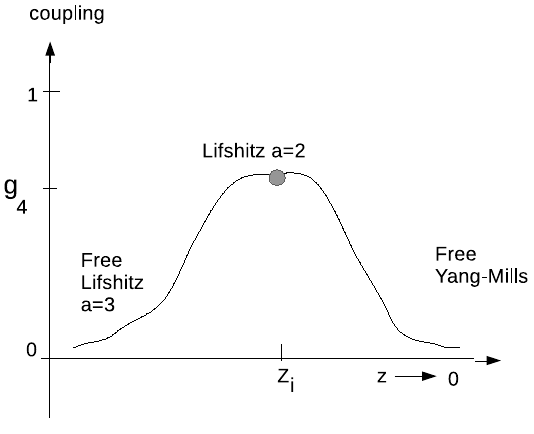
Figure 1 . There is a fixed point at z = z i where coupling is maximum g it the coupling decreases. The two phases both of weak couplings, the ‘confining’ Yang-Mills type (for z c = 0) and ‘deconfined’ Lifshitz a = 3 type (if z 0 6